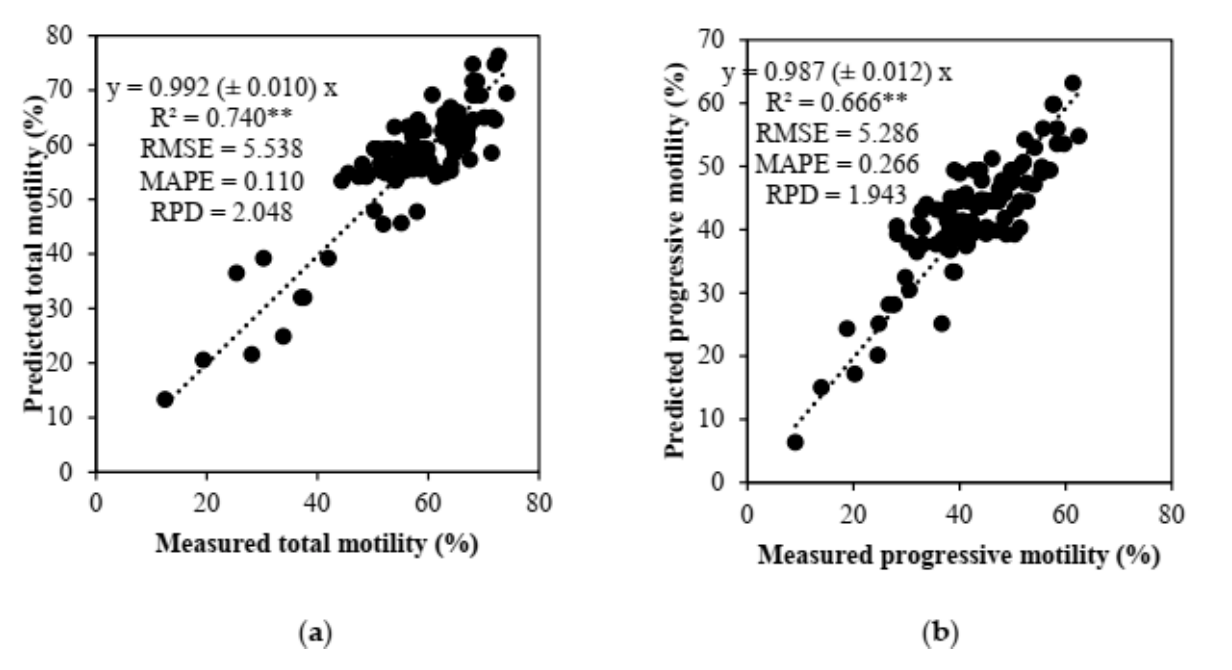
Figure 3. Relationship between predicted values of total ( a ) and progressive ( b ) motility and measured data ( n = 100). Predicted values are generated by the PLS regression models. The model’s performance for PLS is shown by R 2 (coefficient of determination), RMSE (root mean squared error), MAPE (mean absolute percentage error), and RPD (relative percent difference). The numbers in parentheses are the standard errors. ** p ≤ 0.01.